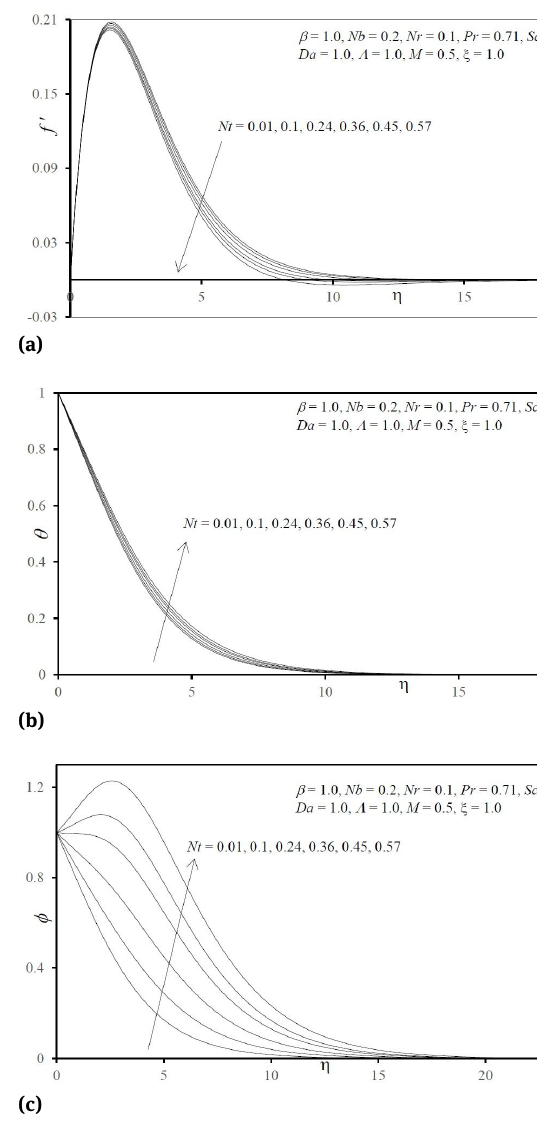
Fig. 4: (a) Influence of Nb on Velocity Profiles; (b) Influence of Nb on Temperature Profiles; (c) Influence of Nb on Concentration Profiles